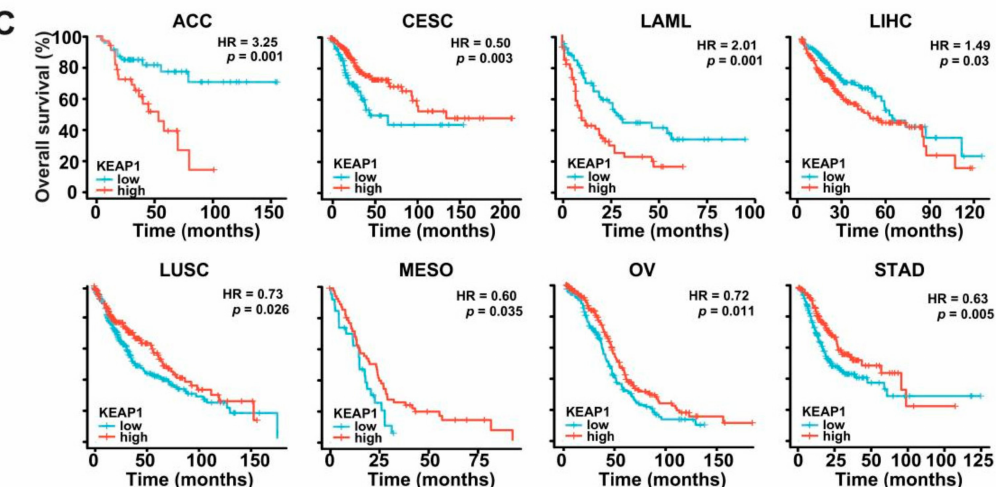
Figure 1. KEAP1 expression across cancers and its prognostic implications. ( A ) Box plots showing the distribution of KEAP1 mRNA expression in 17 types of cancer versus normal tissues based on the TCGA database. * p < 0.05, ** p < 0.01, *** p < 0.001. ( B ) ROC analysis of KEAP1 expression